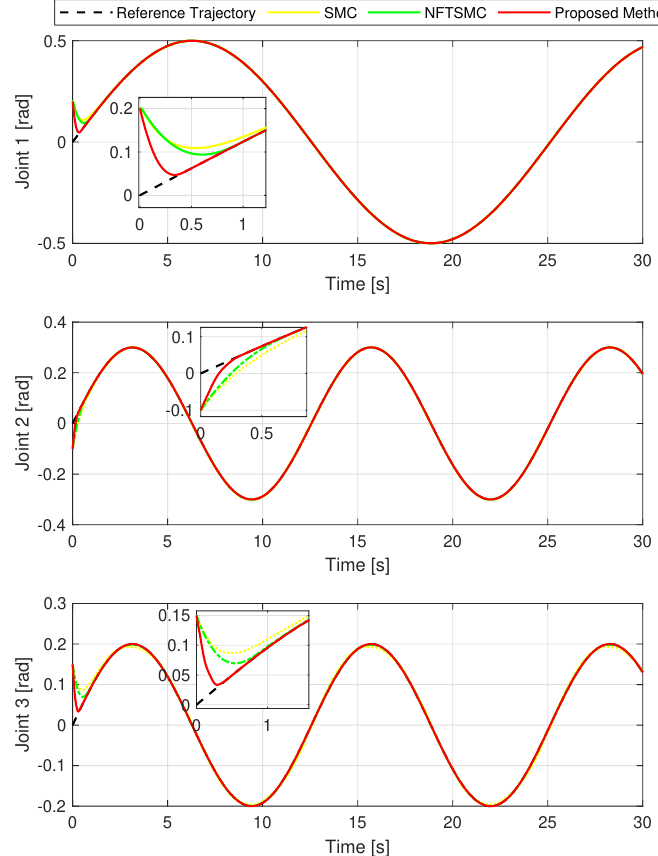
Figure 6. The real trajectory positions under three controllers versus the desired path.